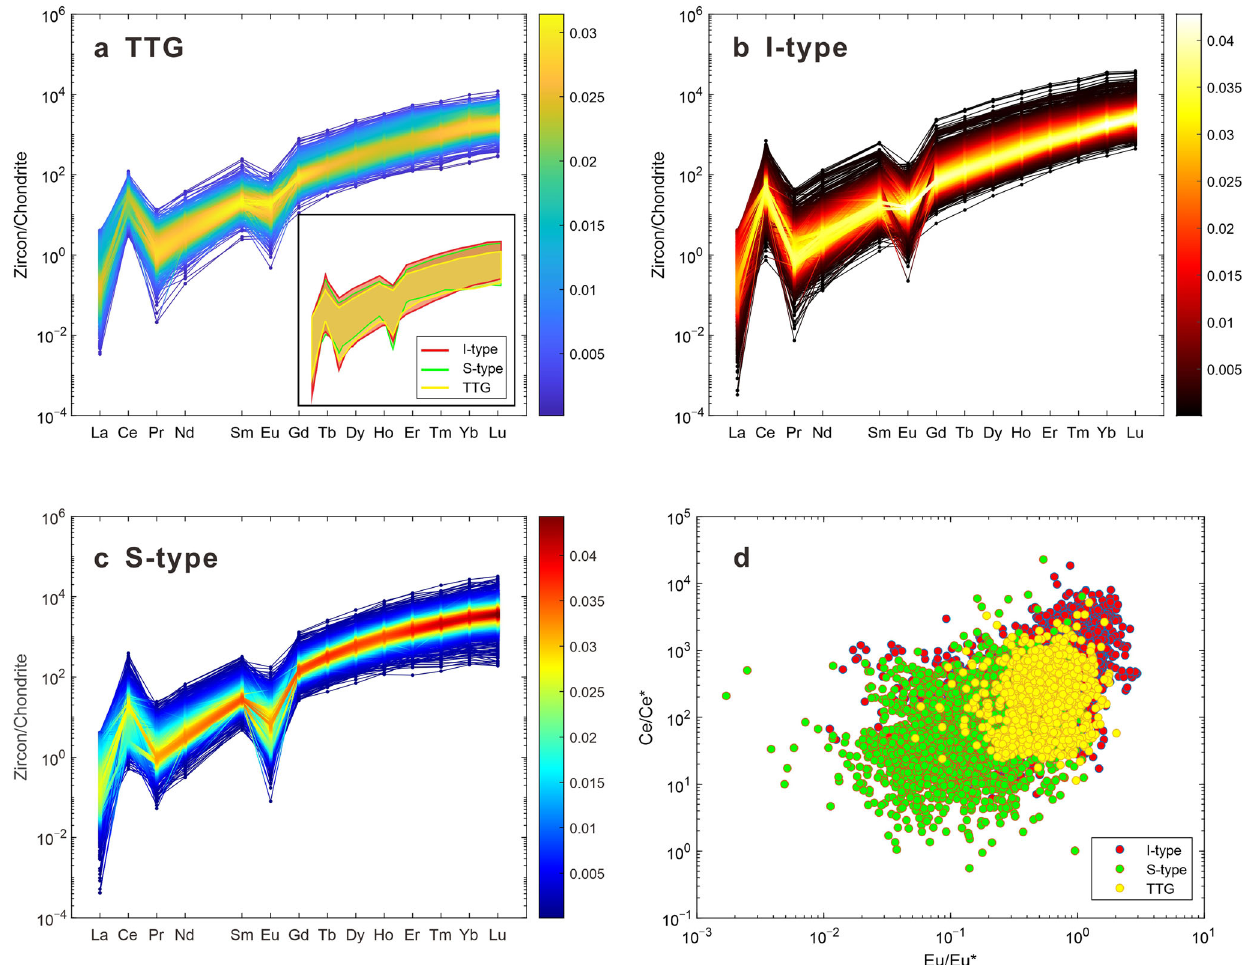
Fig. 1 Zircon trace element diagrams. Kernel density plots of chondrite-normalized REE patterns are shown for zircons from TTGs ( a ), I-type ( b ) and S-type ( c ) rocks. d . Zircon Ce/Ce* versus Eu/Eu* diagram (red circles for I-type zircons, green circles for S-type zircons and yellow circles for TTG zircons). a - c were generated using the ksdensity normal kernel smoothing function in Matlab. Chondrite values are from Sun and McDonough 92 . The exponential power function, as described by Zhong et al. 38 , was used to calculate Ce/Ce* and Eu/Eu* in d